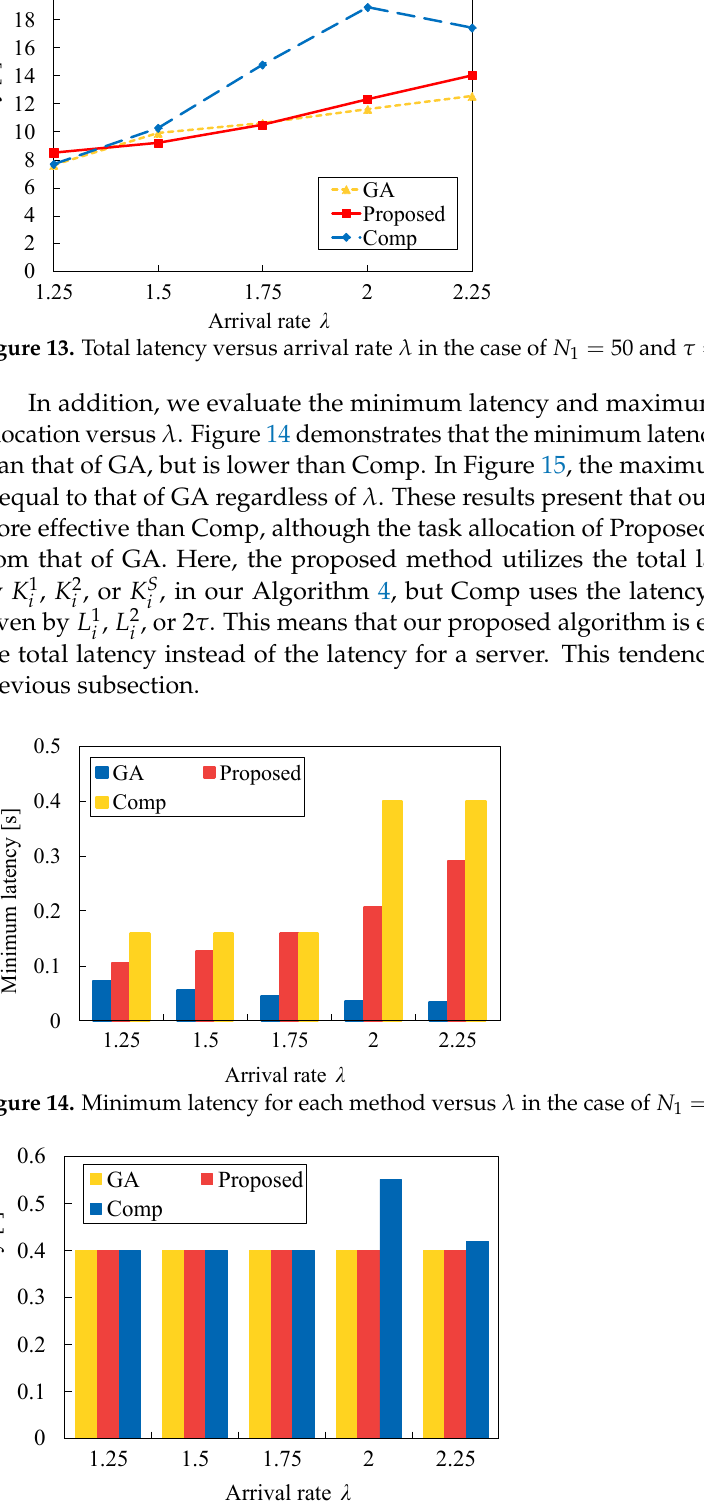
Figure 15. Maximum latency for each method versus λ in the case of N 1 = 50 and τ =